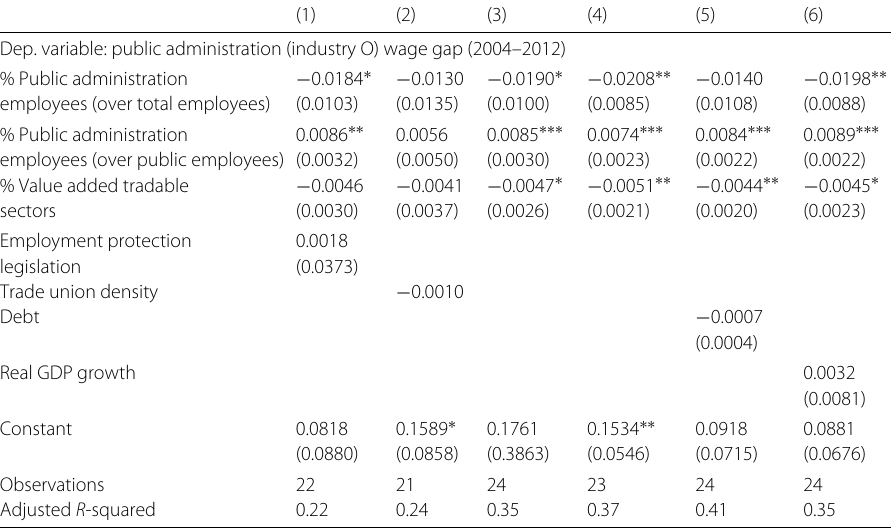
Table 11 Determinants of the public administration pay